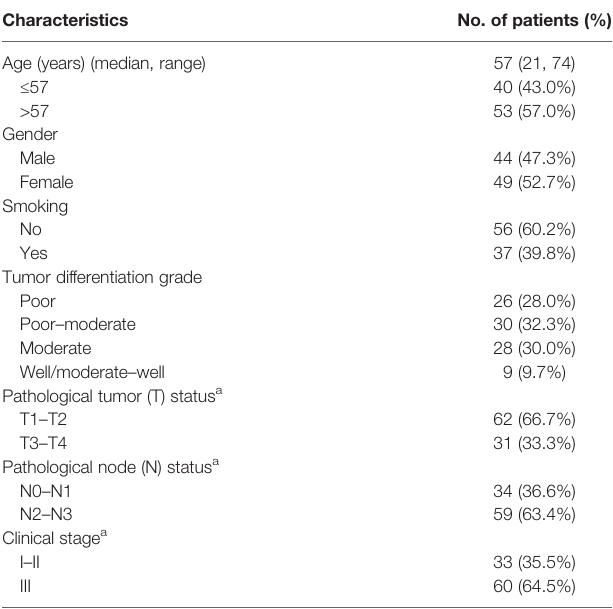
TABLE 4 | Clinical characteristics of 93 patients with lung